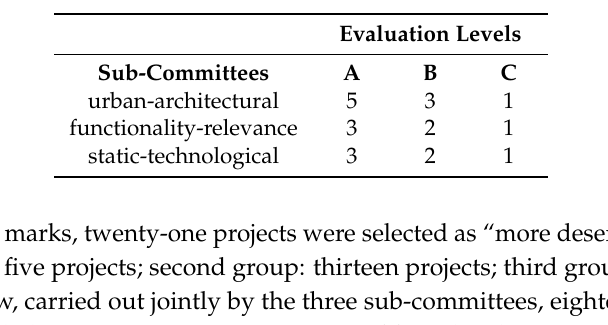
Table 2. Marks according to the evaluation levels of the